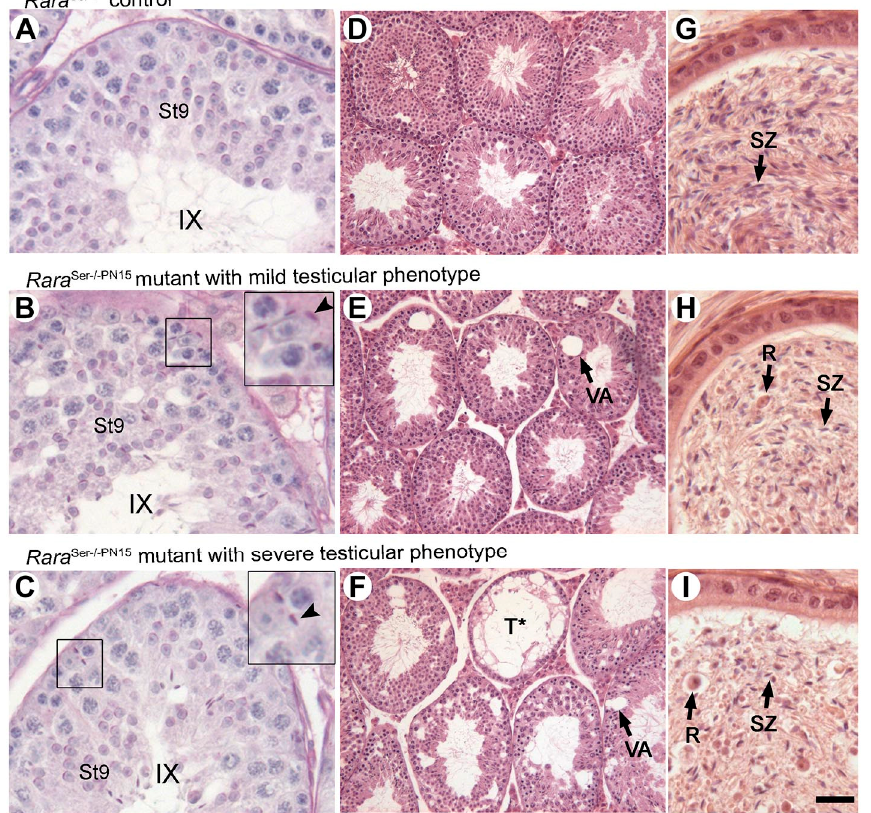
Figure 6. Loss of RARA in Sertoli cells from PN15 yields seminiferous epithelium defects in adulthood. Histological analyses of testis and epididymis of 4-month-old control and Rara Ser − / − PN15 mice. ( A – C ) PAS stains of histological sections through the testis, illustrating retained mature spermatids at epithelial stage IX in Rara Ser − / − PN15 mutants. The insets show high-magnification views of the boxed areas. Arrowheads point to retained mature spermatids. ( D – F ) HE stains of histological sections through the testis, illustrating vacuolation of the seminiferous epithelium in Rara Ser − / − PN15 mutants. ( G – I ) HE stains of histological sections through the caudal epididymis. The epididymis of Rara Ser − / − PN15 mutants contains fewer spermatozoa (compare SZ in G – I ) but numerous round germ cells. Legend: R, round immature germ cells; St9, step 9 of spermatid maturation; SZ, spermatozoa; T*, tubule depleted of germ cells; VA, vacuoles; IX, epithelial stage. Scale bar: 75 μ m in ( A – C ) and ( G – I ); 150 μ m in ( D – F ).